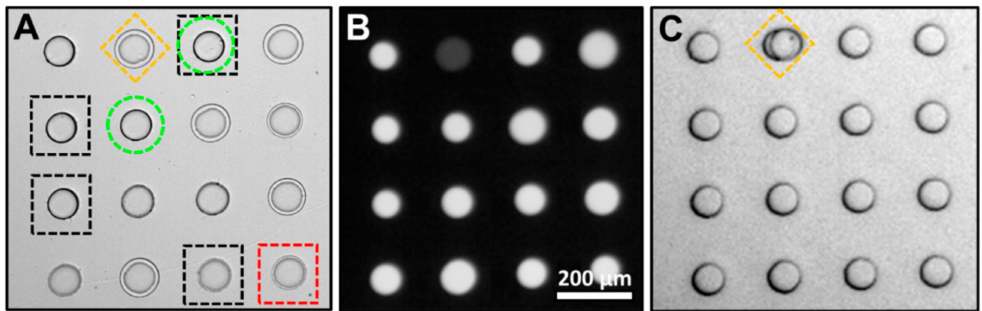
Figure 4. ( A ) Bright-field image of droplet array. Droplets containing cells were classified as viable (green circle), early apoptosis (yellow diamond), late apoptosis (red square), and necrosis (black square). ( B ) Fluorescence image with blue excitation. The droplet with an early apoptosis cell was irradiated and displays lower fluorescence intensity. ( C ) Droplet array after the elution of non-irradiated droplets. The only droplet remaining in the array contains the early apoptosis